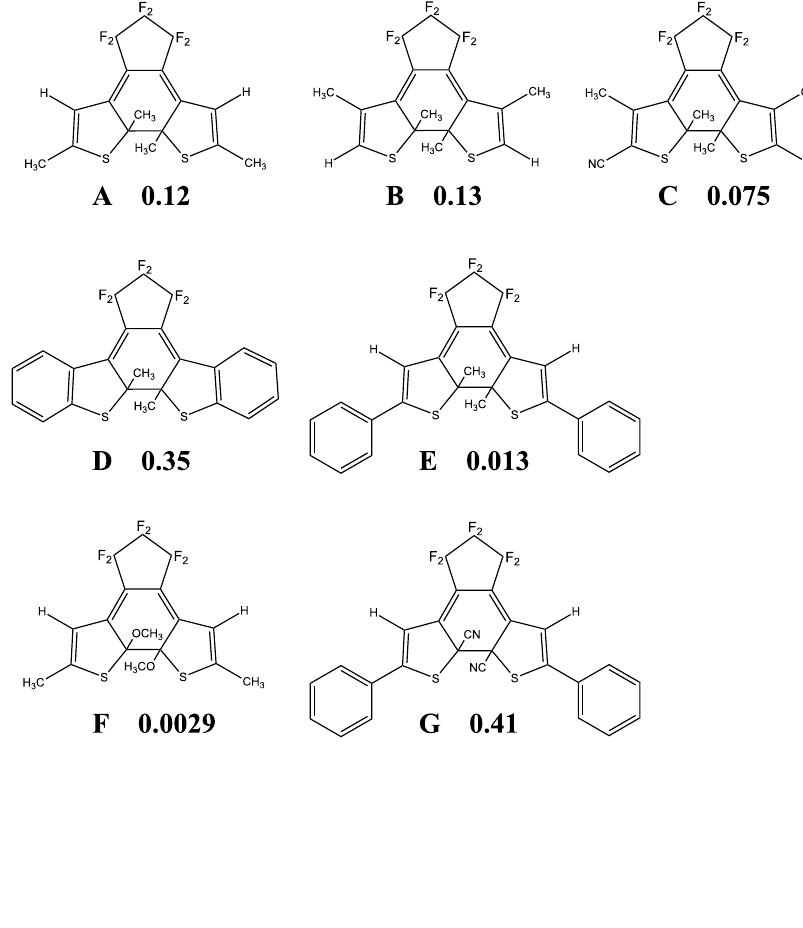
Figure 3. Experimental QYs for